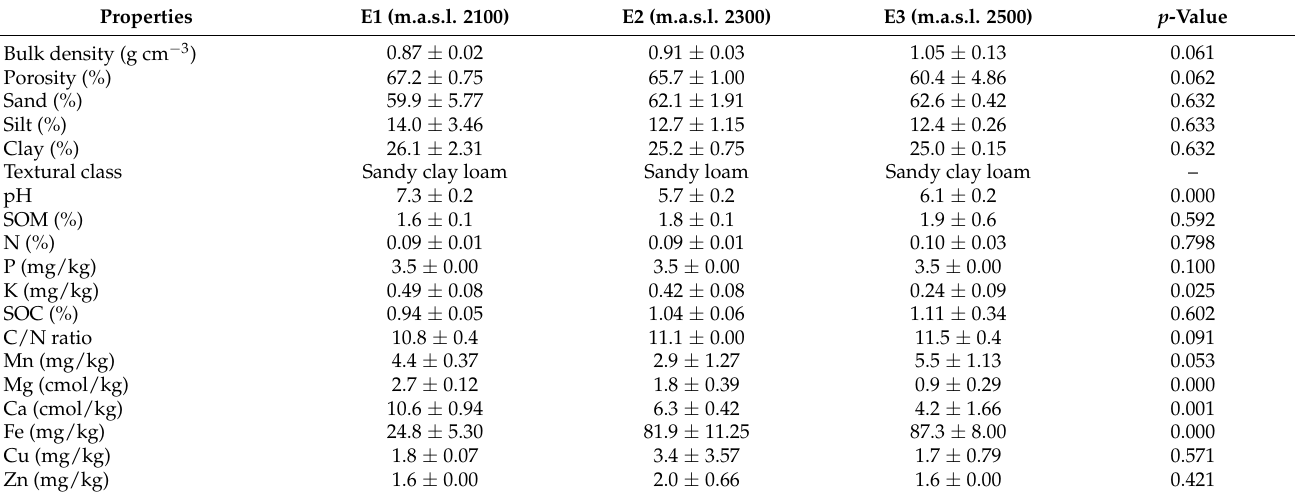
Table 2. Results of one-way ANOVA of main physical-chemical properties of the soil at the different elevations studied.